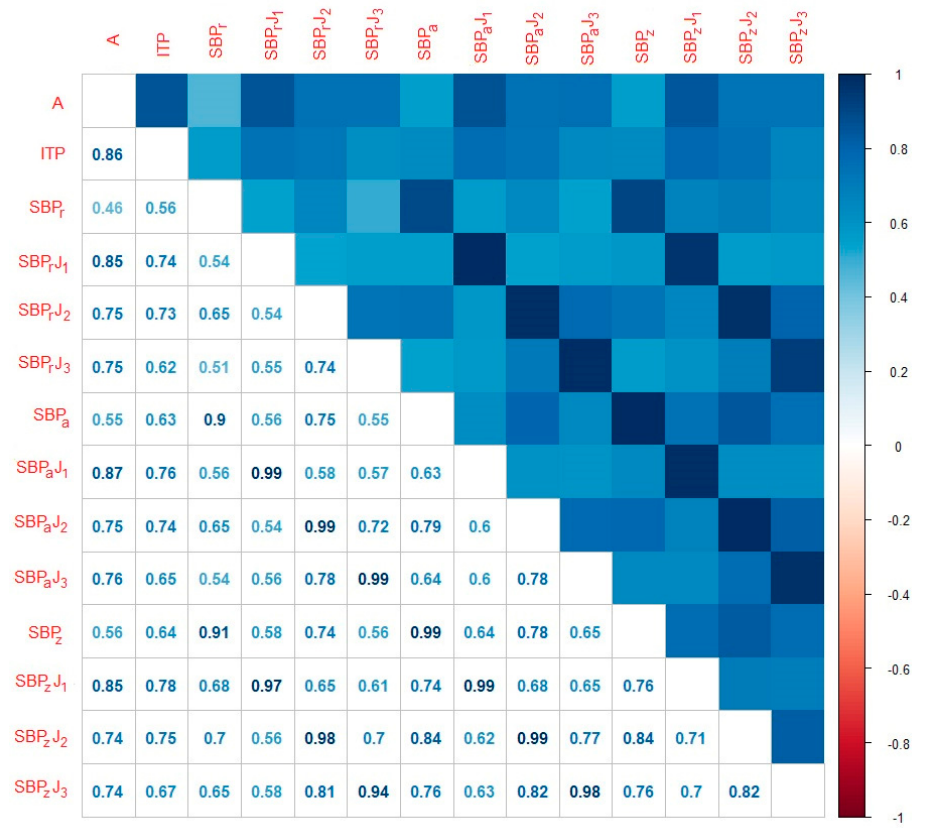
Figure 6. Pearson’s correlation coefficients between different versions of tree-ring δ 18 O chronologies over the period 1958–2007.